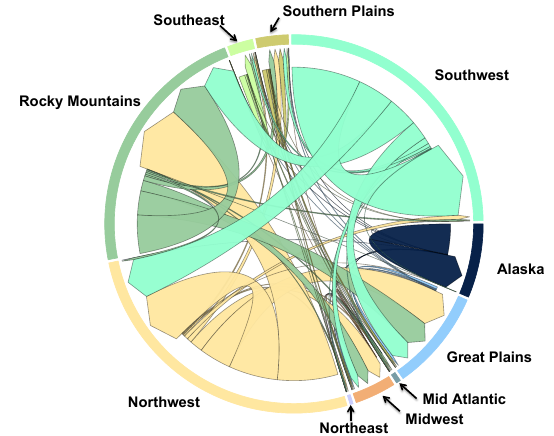
Figure 13. US regions smoke hour climatology for June–September 2007–2014 using GDAS1 meteorology. Arrows indicate the smoke hours’ source region and destination region. The widths of arrows are proportional to total smoke hours transported between regions. Each of the 10 US regions makes up a fraction of the total circum- ference of the circle, which is proportional to the total smoke hours over and produced by all US regions. The widths of the arrows are proportional to the number of smoke hours in a given transport path- way. The colors of the arrows match the source region of the smoke hours (Fig. 6). This figure places the individual histogram of Fig. 11 into